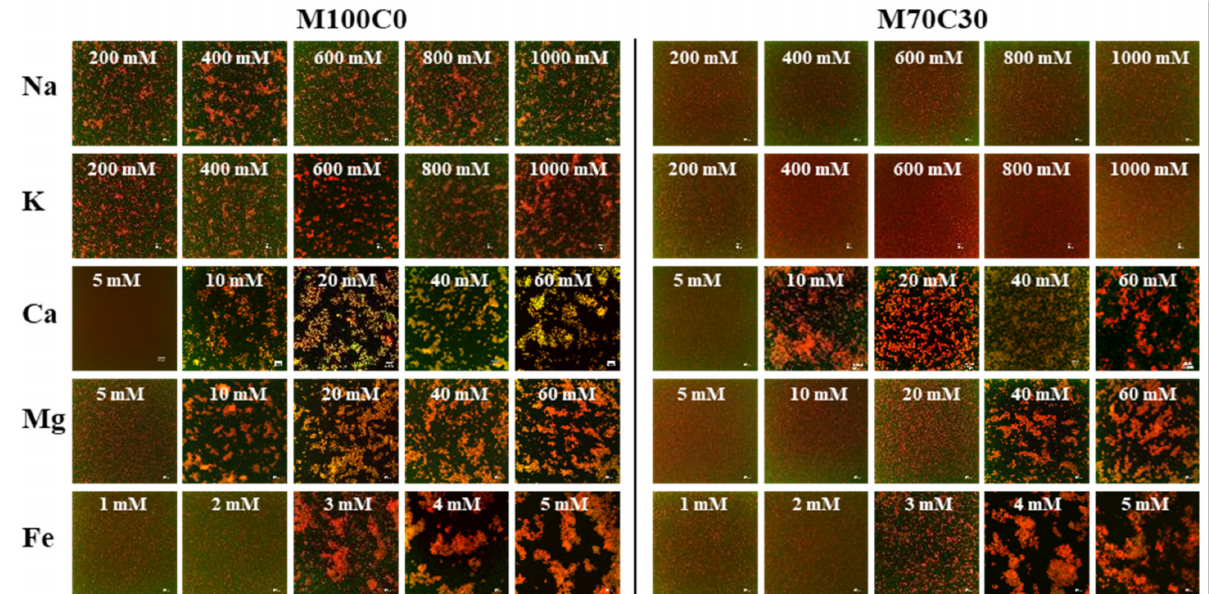
Figure 3. CLSM images of WPI-stabilized emulsions at different ion types and strengths. The pictures are overlays of Nile red-labeled oil phase and FITC-labeled protein. The scale bar is 20 µ